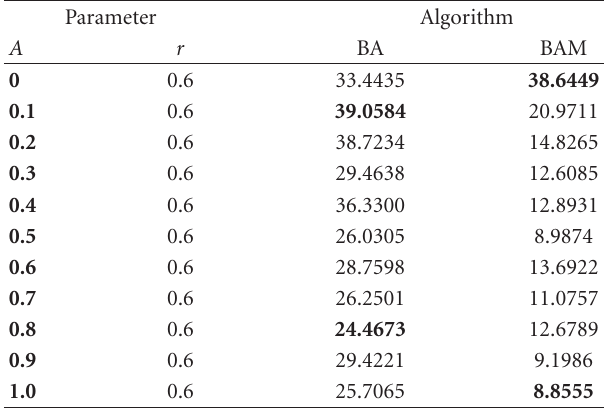
algorithm, averaged over 100 Monte Carlo runs. In other